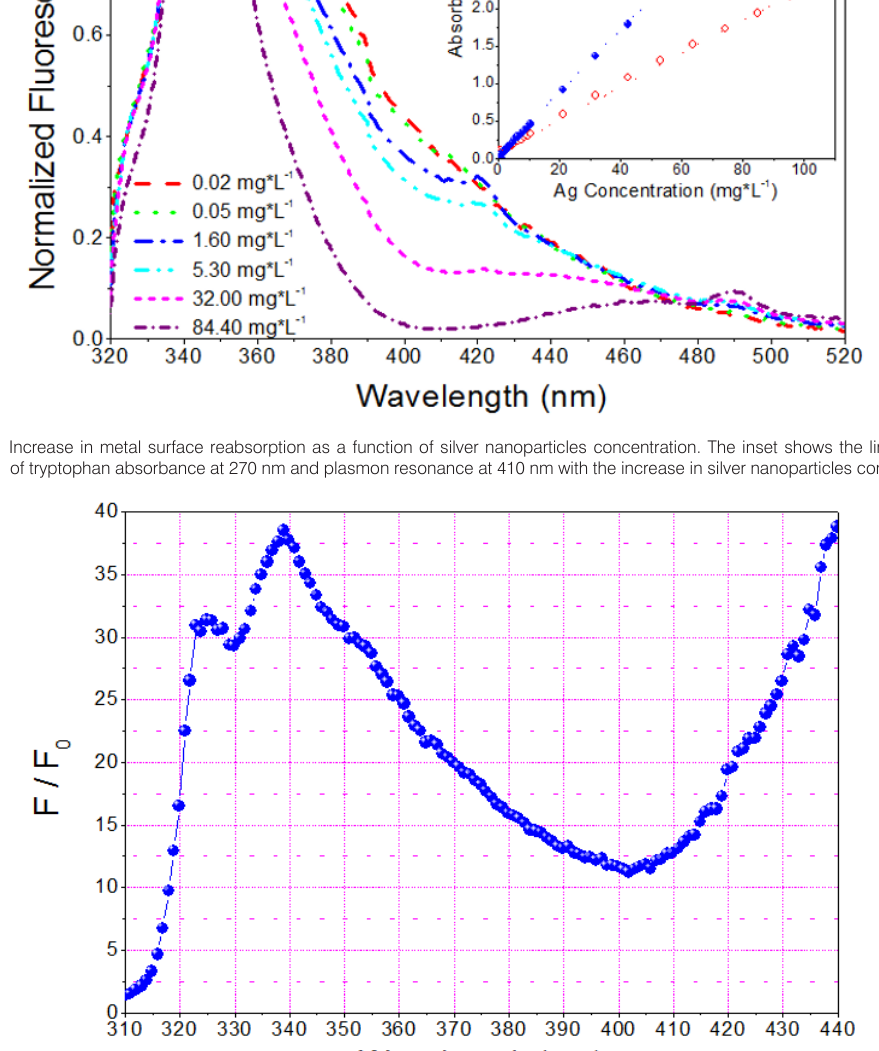
) obtained at 32 mg L -1 0 In order to understand the importance of the metal